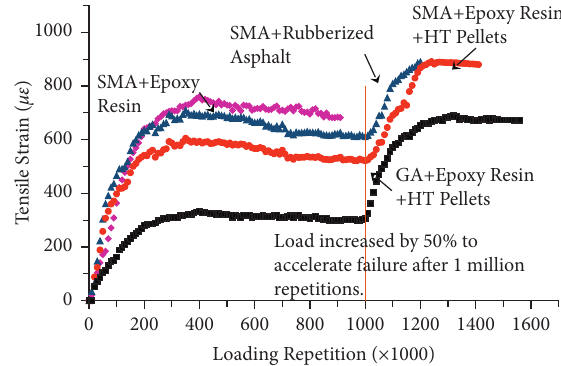
Figure 15: FPBT fatigue test results.